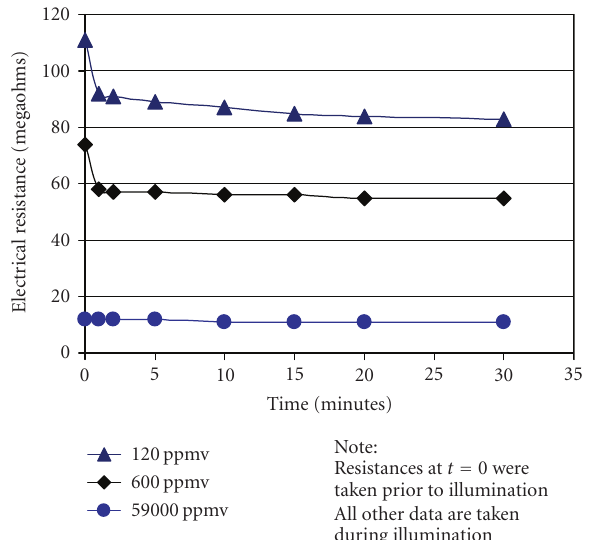
Figure 4: Substrate response after humid air was spiked ethanol and illuminated. Resistances at t = 0 reflect the surface’s electrical resistance in the dark prior to the lights being turned on.